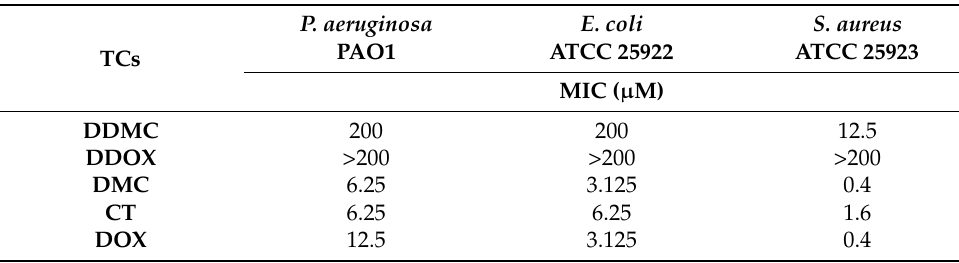
Table 1. Antimicrobial activity of TC